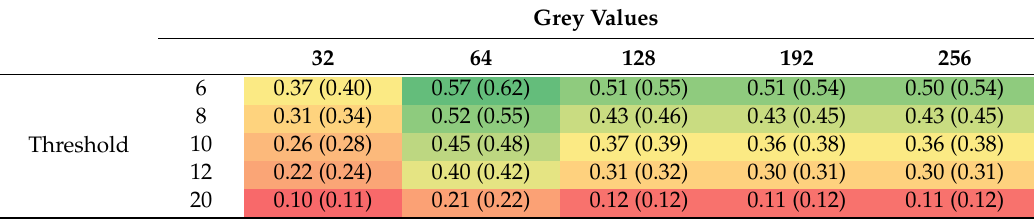
Table 4. Proportion of matching stones between the automatic detection method and the total amount of the manual detection method (n = 12,852) under di ff erent frame conditions using the 1.50 m bu ff er size (3.00 m in parentheses). Color scale indicates high values in green and low values in